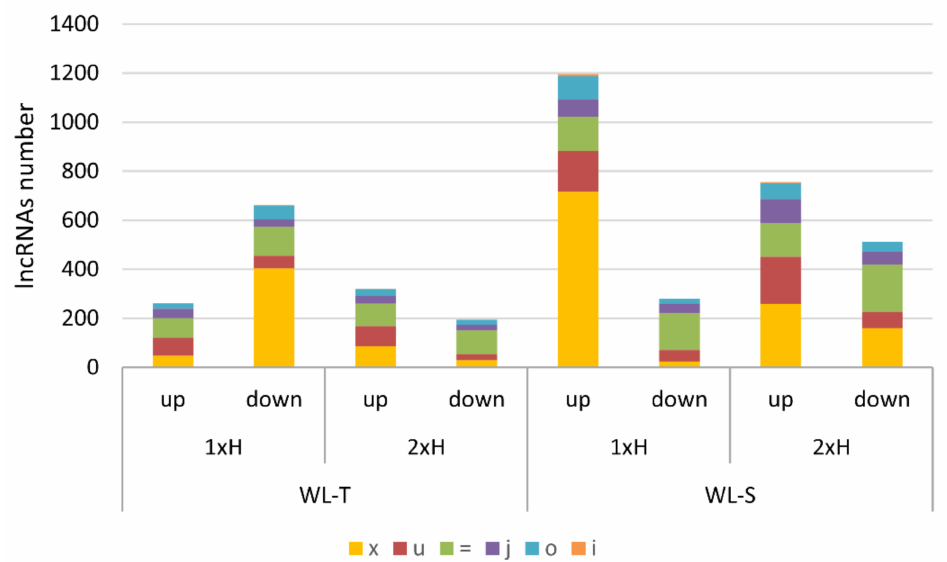
Figure 2. Distribution of lncRNAs due to genome localization among differentially expressed lncRNAs in two cucumber accessions (WL-T and WL-S) under waterlogging (1xH and 2xH) in comparisons to control conditions. ‘x’—exonic overlap with reference on the opposite strand, ‘u’—intergenic lncRNA, ‘=’—complete match of intron chain, ‘j’—potentially novel isoform (frag- ment): at least one splice junction is shared with a reference intron, ‘o’—generic exonic overlap with a reference transcript, ‘i’—intronic lncRNA.